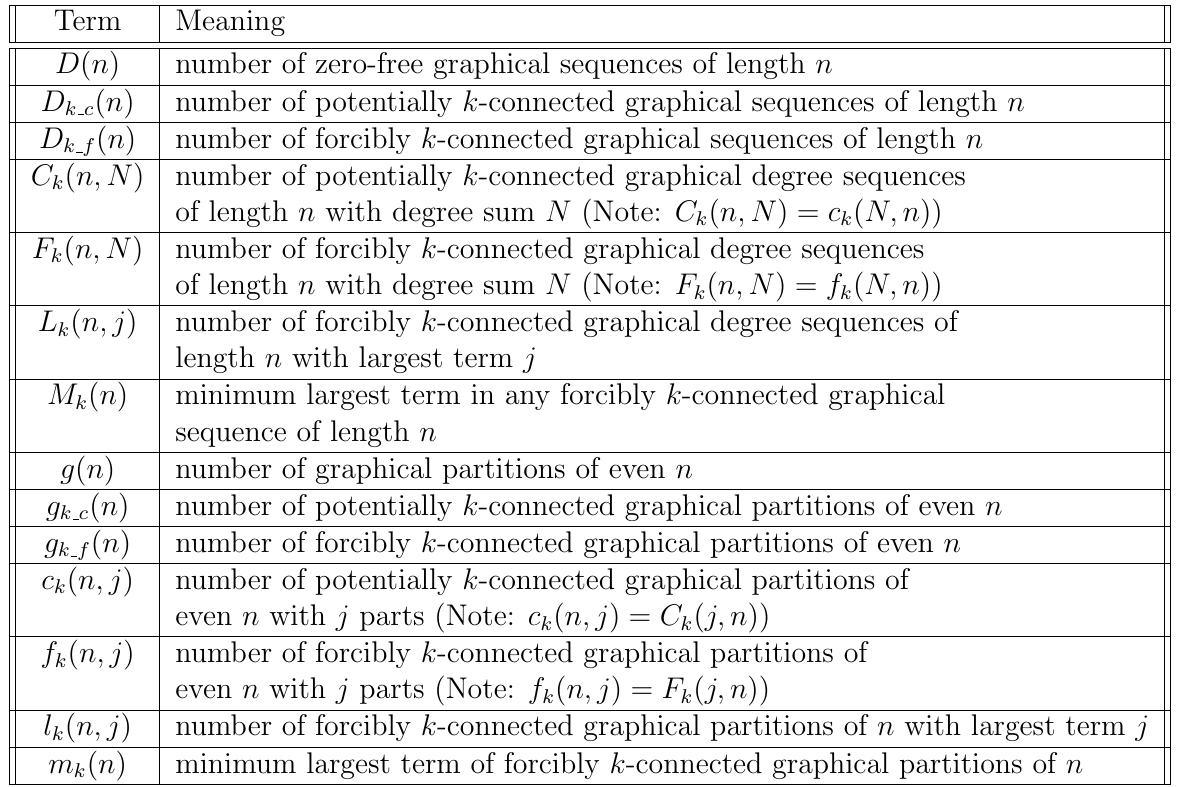
Table 2: Terminology used in Section